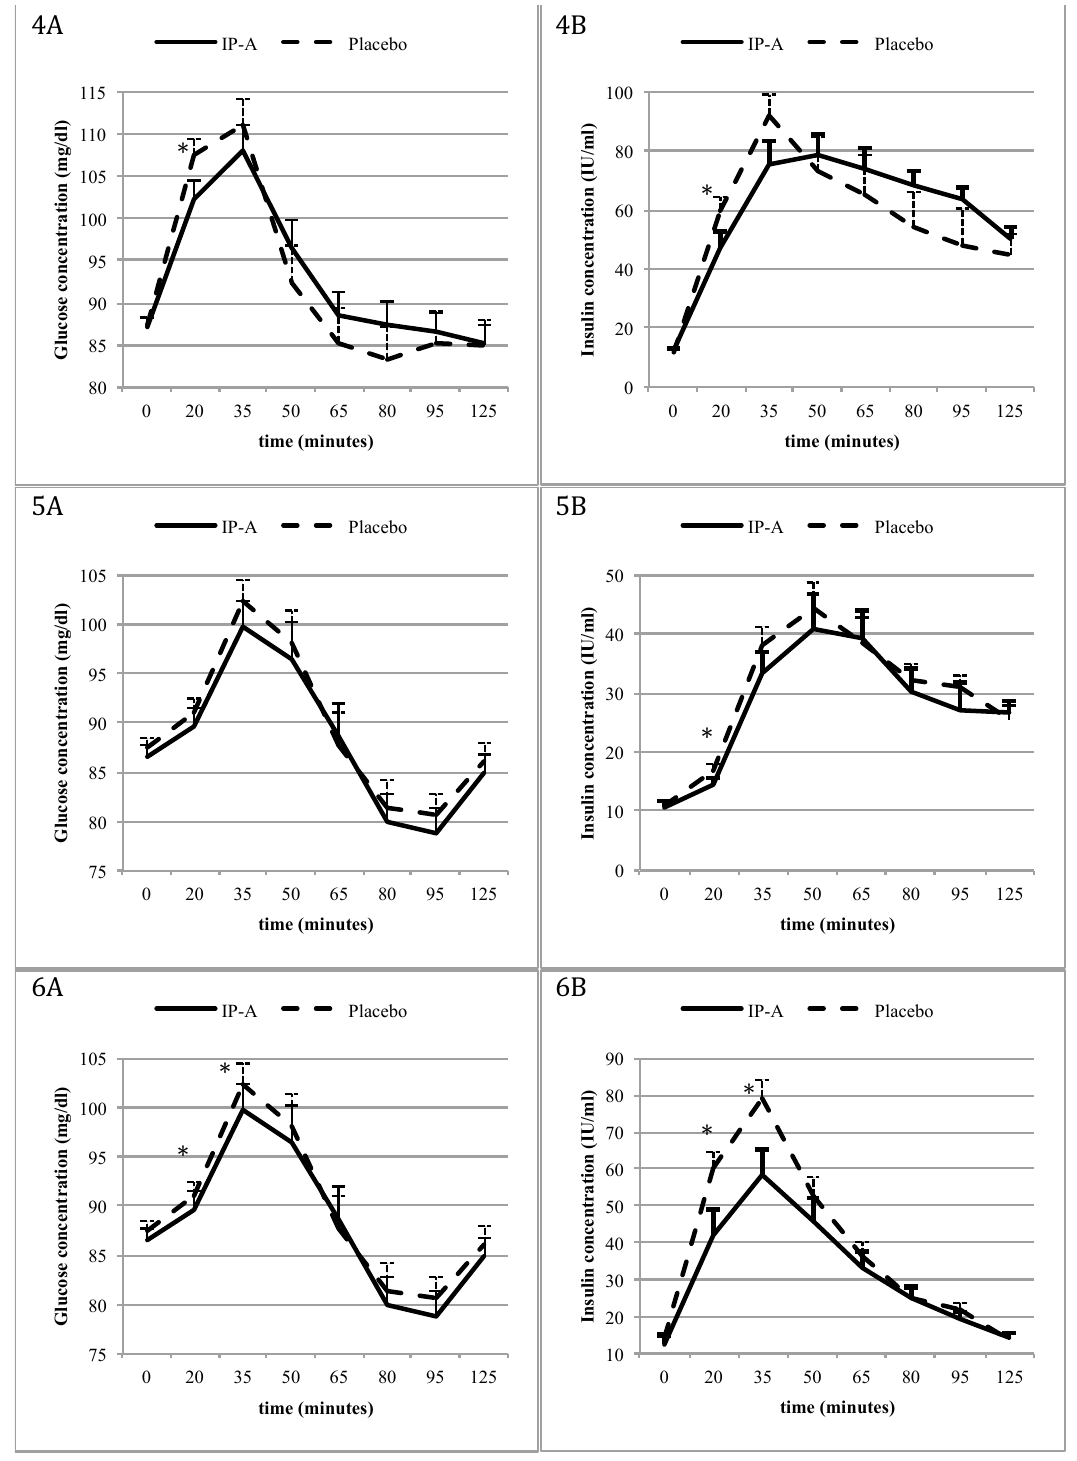
Figure 2. Fasting and postprandial ( A ) glucose (mg/dL) and ( B ) insulin (IU/mL) concentrations after investigational product-A (IP-A, solid lines) vs. placebo (dashed lines) administration during meal